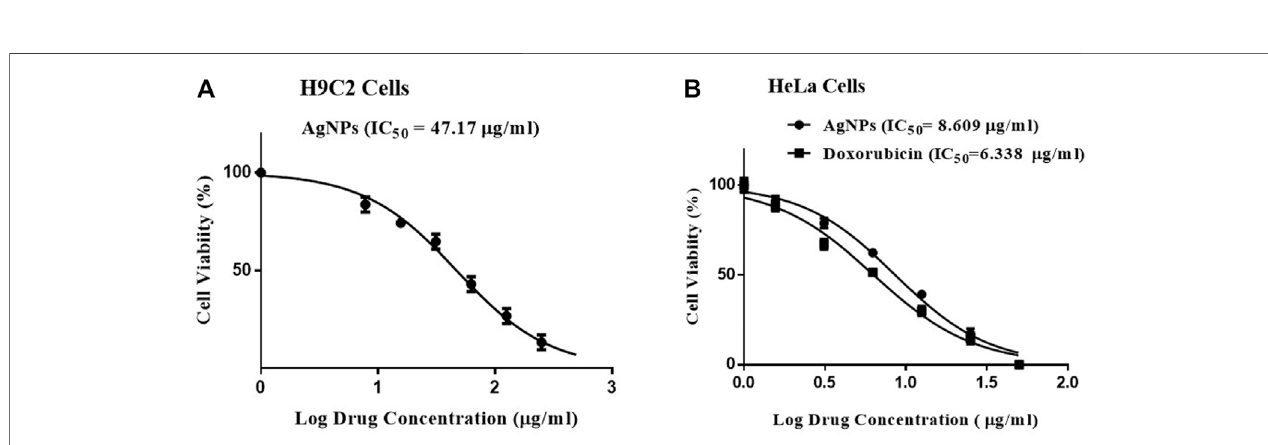
FIGURE 5 | (A,B) Cytotoxicity measured in vitro by MTT assay. (A) Biogenic Ag-NPs on H9C2 cell lines, (B) Biogenic Ag-NPs and doxorubicin treatment on HeLa cell lines.